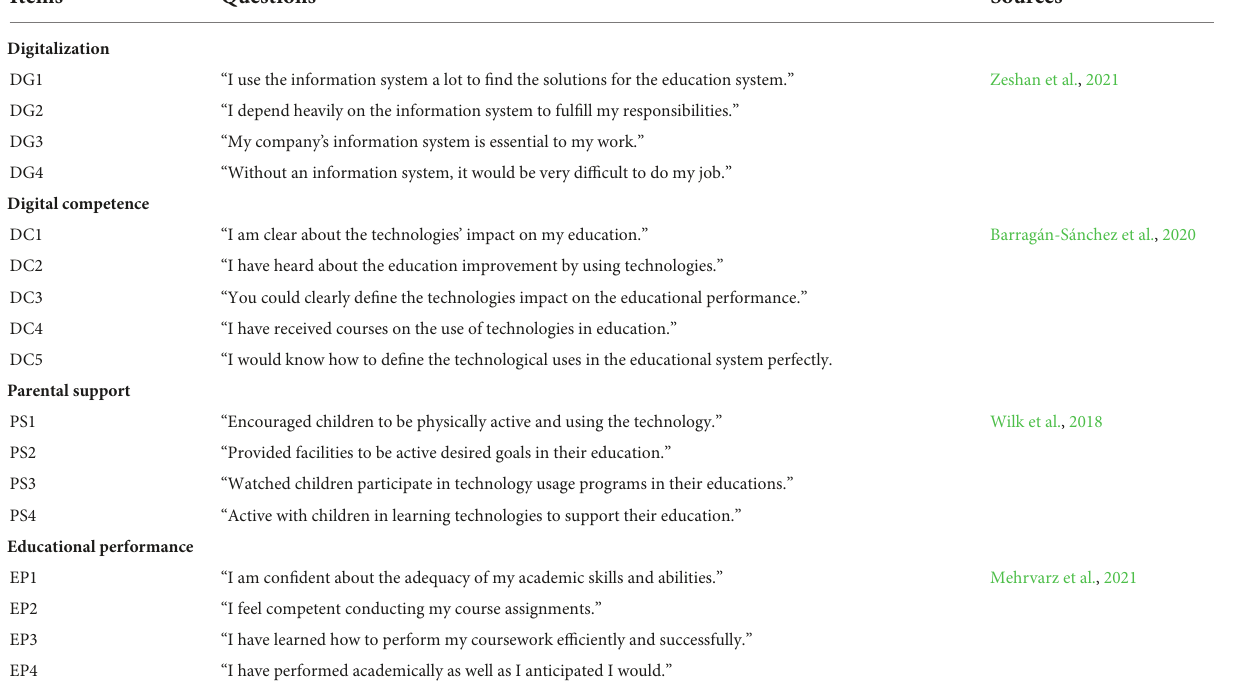
TABLE 1 Measurement of the